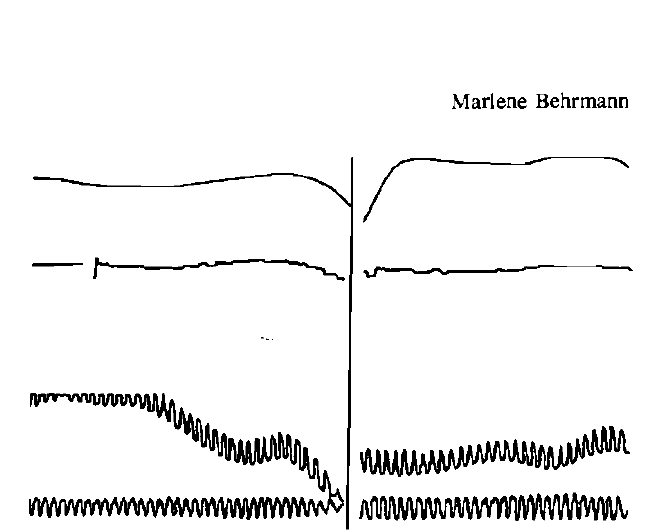
Figure lb Examples of pre-intervention laryngographic tracings during reading ity and erratic movement may be observed in Figures la and lb and these tracings reflect a disturbance in laryngeal functioning and co-ordination as described by Conture et al. (1977). An